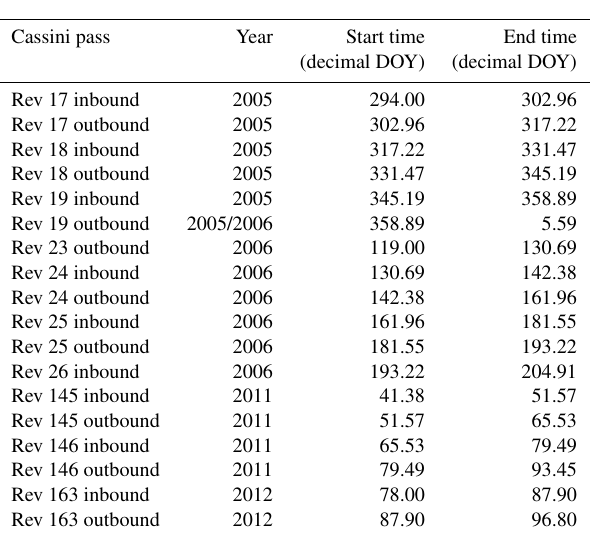
Table 2. Start and end times in year and decimal DOY, correspond- ing to Cassini apoapsis and periapsis, or vice versa, for each of the passes employed in this study.